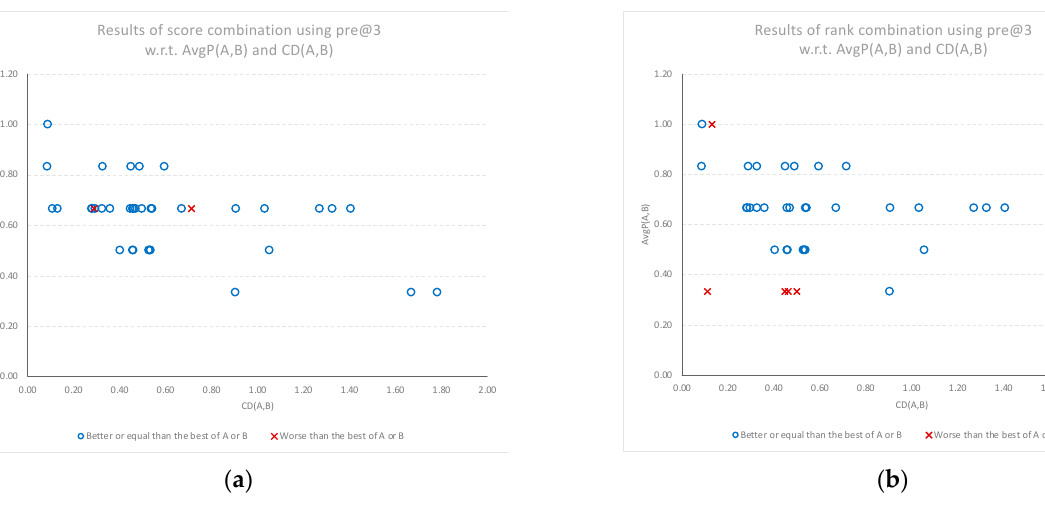
Figure 7. Relative performance of the combined models compared to the best of the individual models (best of A or B) for the top three classifications, plotted against the average performance (AvgP) of the individual models and cognitive diversity. ( a ) Results when using score combination SC ( A , B ). ( b ) Results when using rank combination RC ( A , B ).